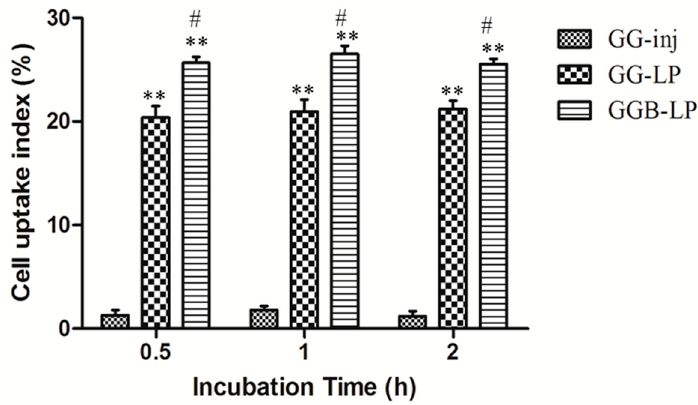
Figure 5. In vitro bEnd.3 cell uptakes of GGB-LP, GG-LP, and GG-inj during incubation at 37 °C (mean ± SD, n = 3), ** p < 0.001, vs. GG-inj; # p < 0.05, vs. GG-LP.